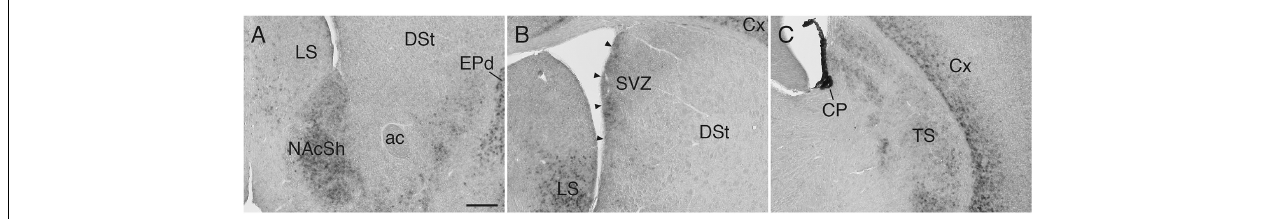
FIGURE 2 | Sulf1 mRNA expression in the striatum. (A) Sulf1 was expressed in the nucleus accumbens shell (NAcSh). (B) Sulf1 was detected in the subventricular zone (SVZ) of the lateral ventricle (arrowheads) and the ventral part of the lateral septal nucleus (LS). (C) Sulf1 was observed in the posterior tail of the striatum (TS) and layer 6 of the cerebral cortex (Cx). The strongest Sulf1 expression was observed in the choroid plexus (CP). ac, anterior commissure; DSt, dorsal striatum; EPd, endopiriform nucleus dorsal part. The scale bar indicates 250 µ m. Approximate AP levels from the bregma (in mm) are 1.0 (A) , 0 (B) , and –1.0 (C)